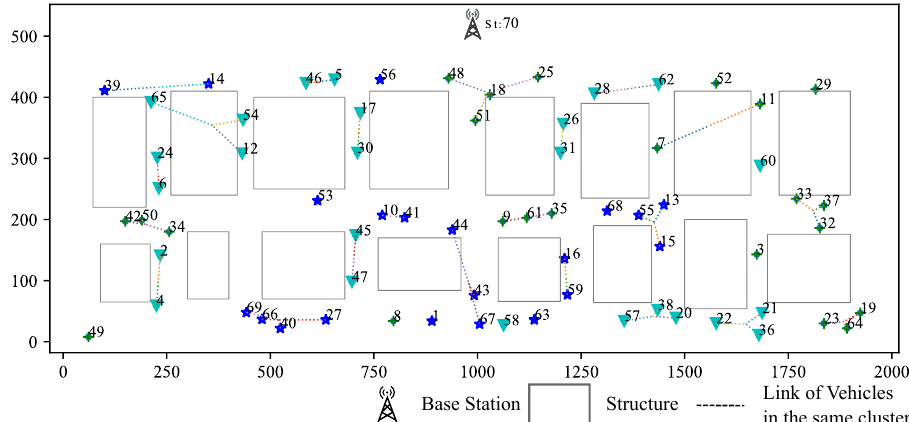
Figure 10. σ -Clustering Algorithm According to path loss and location.